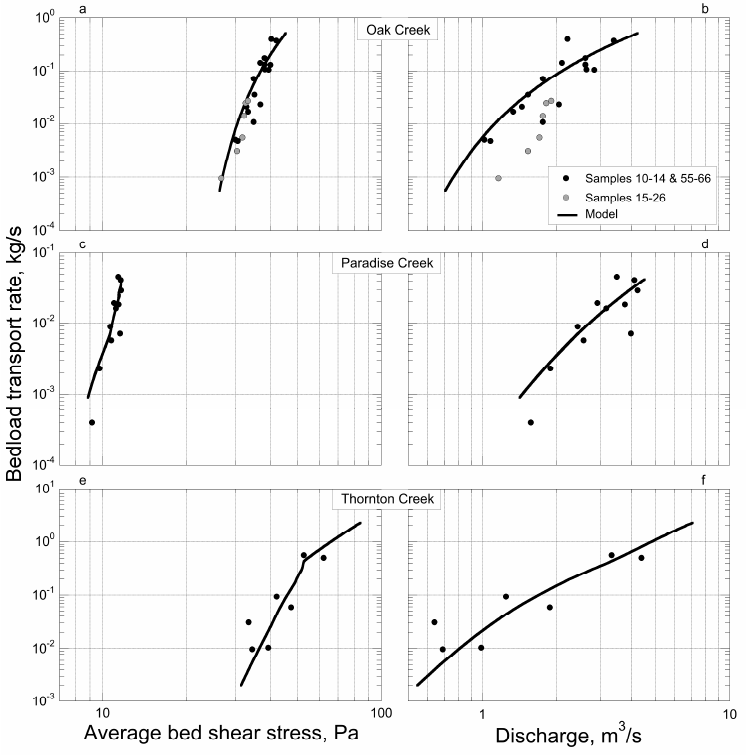
Figure 4. Total bedload transport versus cross-section average bed shear stress (left) and versus discharge (right). ( a , b ) are Oak Creek, Oregon (Milhouse, 1973). All samples shown, taken during the winter of 1971 at discharges greater than 1 m 3 /s, were used for calibration. Site hydraulics were different for the 6 samples shown in grey, which required use of a separate equation relating water surface elevation to discharge. These samples were used in calibration but are not well described by the model curve when displayed against discharge. ( c , d ) are Paradise Creek, Oregon. ( e , f ) are South Fork Thornton Creek, Seattle, Washington. Inflexions of the Paradise Creek and South Fork Thornton Creek model curves are due to inflexions in channel cross section and use of multiple water-level to discharge rating equations.